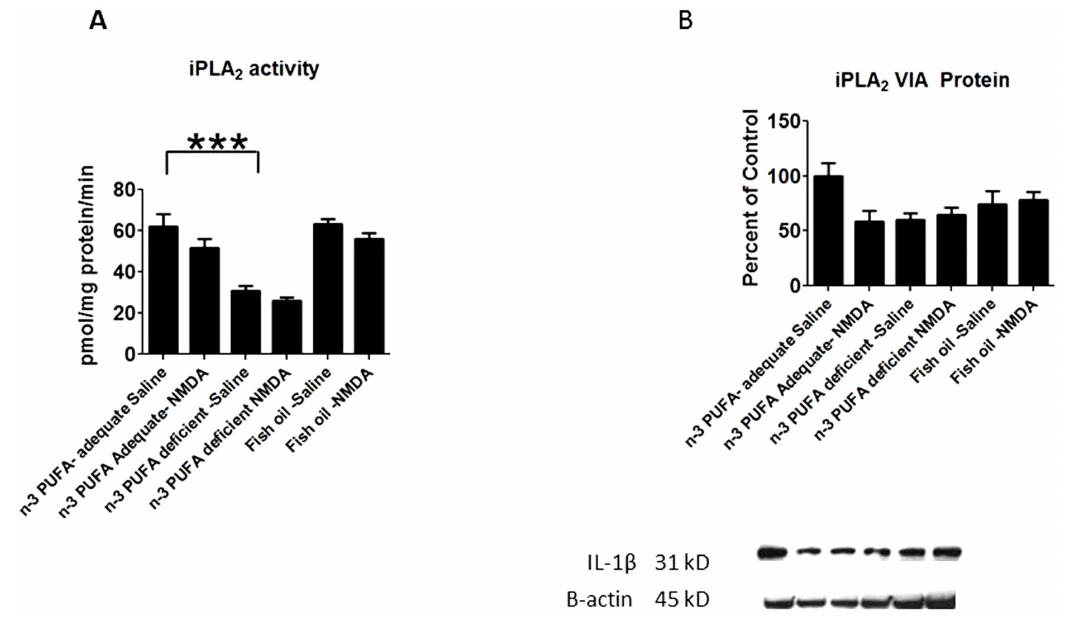
Figure 4 iPLA 2 activity and protein expression. Measured activity of A) iPLA 2 enzymes and B) iPLA 2 protein levels. Data are expressed as mean 6 SEM (n=6 per group for activity, and 5 per group for protein due to one unquantifiable band per group). Statistical significance is denoted by * p # 0.05, ** p , 0.01, *** p , 0.001.